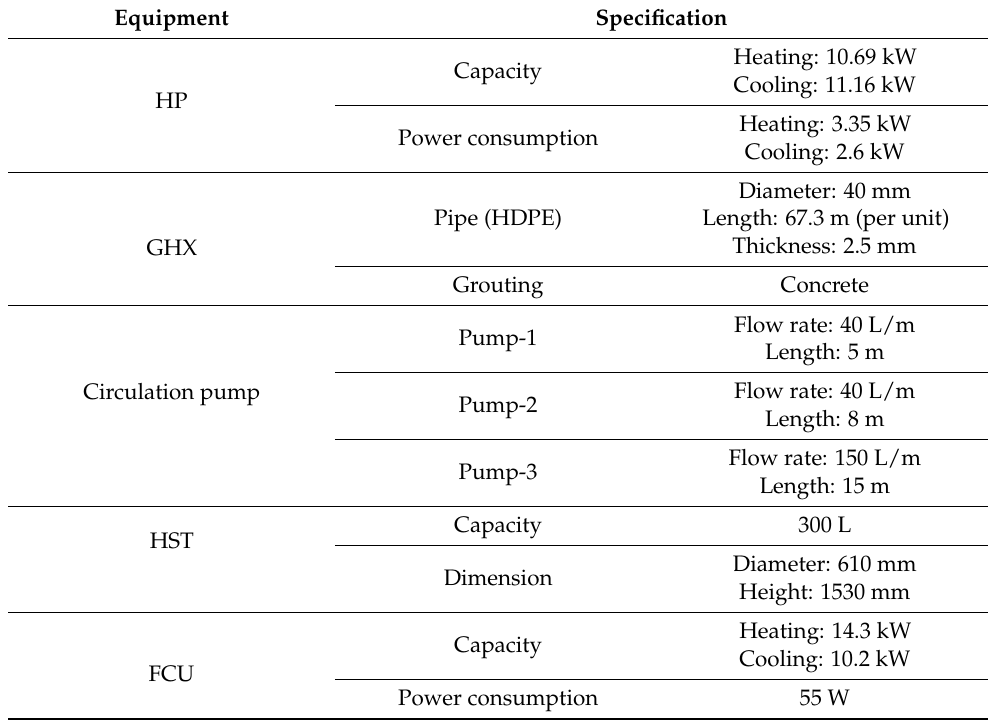
Figure 8. Picture of real-scale experiment site. Table 3. Specification of